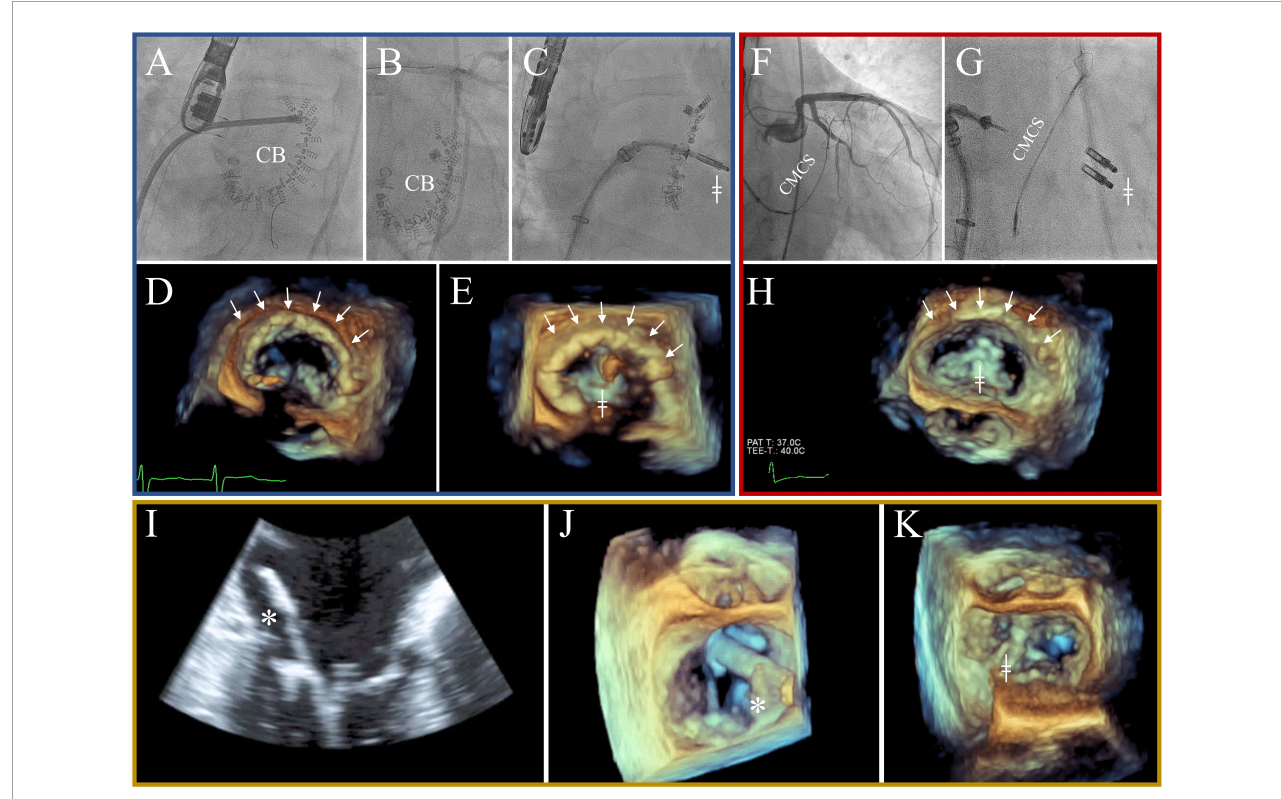
FIGURE1 All three combination (COMBO) strategies with blue: Cardioband + mitral transcatheter edge-to-edge repair (M-TEER) (A–E) , red: Carillon Mitral Contour System (CMCS) + M-TEER (F–H) , and orange: Neochord + M-TEER (I–K) . Blue: Cardioband is implanted using fluoroscopy [A + B; “Cardioband (CB)” and arrows] and 3D echocardiography (D) . Intermittently, unimpaired flow of left circumflex coronary artery (LCX) is checked (B) . Red: CMCS is implanted using fluoroscopy (F + G). Intermittently, unimpaired flow of LCX is checked (F) . Note the pull of the CMCS in the left atrium displayed in 3D echocardiography (arrows). Orange: Neochord is implanted using echocardiography [2D: (I) and 3D: (J) ]. Please note the open jaws of the NeoChord Implanting system, ready to grasp the flailing posterrior mitral leaflet ( ∗ ). MC is implanted second to either Cardioband (C,E) , CMCS (G,H) , or Neochord (K) , using both fluoroscopy, and 3D echocardiography ( }